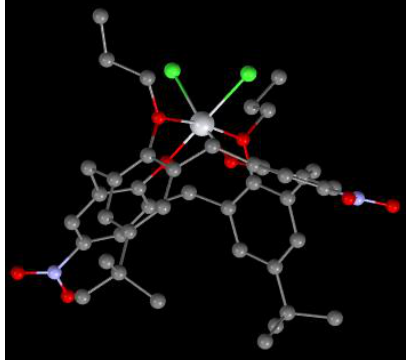
Figure 16. Molecular structure of 64 [30].